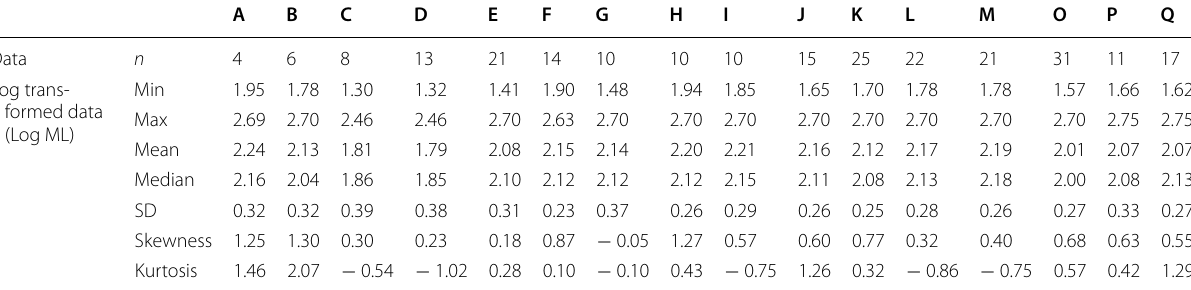
Table 3 Descriptive statistics of mean body size (Log ML) for the 16 biogeographical